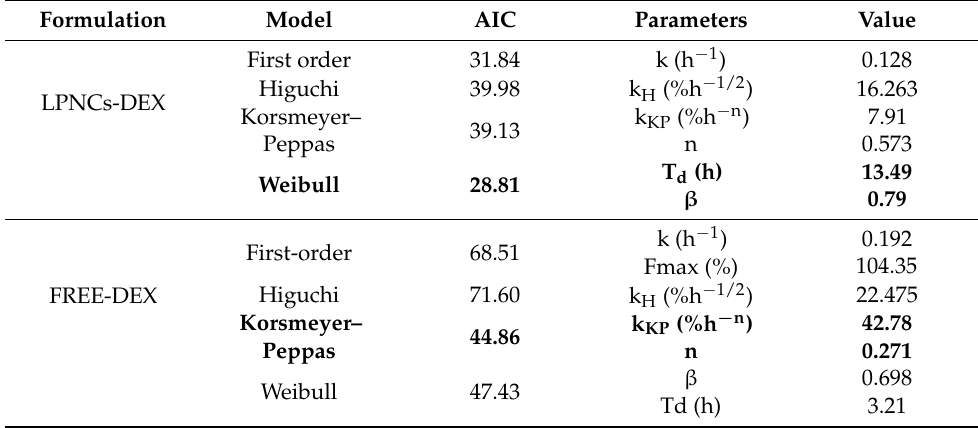
Table 6. Model selection and parameter estimation of the LPNCs-DEX and FREE-DEX. Bold type indicates the selected model, based on the lowest AIC.